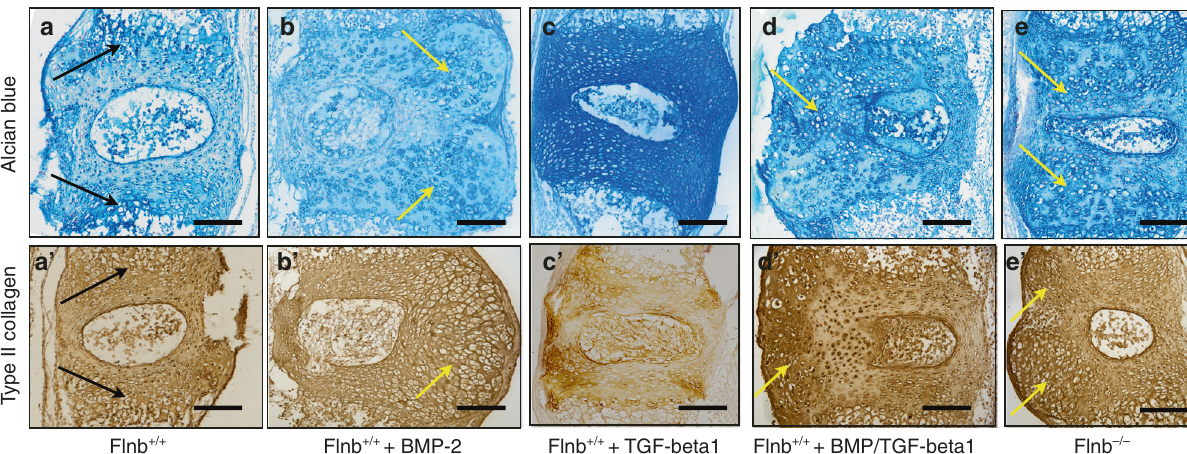
Fig. 5 Flnb + / + IVD stimulation with TGF β -1 and BMP-2 mimics the Flnb – / – phenotype, which is rescued by combinatorial inhibition of TGF β and p38 signaling. a – e Representative images of sagittal sections of T7-T8 cultured IVDs stained with Alcian Blue for proteoglycans. a Flnb + / + cultured spines show proteoglycans concentrated in the articular cartilage (black arrows). b BMP-2-stimulated Flnb + / + spines exhibited no change in proteoglycan secretion but severe disruptions in tissue architecture (yellow arrows). c TGF β -1-stimulated Flnb + / + spines showed no change in tissue architecture but increased proteoglycan secretion. d BMP-2- and TGF β -1-stimulated Flnb + / + spines exhibit increased proteoglycan secretion and disruptions in tissue architecture (yellow arrow). e Flnb – / – spine exhibiting increased proteoglycan secretion and disrupted tissue architecture (yellow arrows). a ’ – e ’ Representative images of sagittal sections of T7-T8 cultured IVDs stained for type II collagen via IHC-HRP. a ’ Type II collagen distribution is more evenly distributed throughout the IVD concentrated in the AC. b ’ BMP-2-stimulated Flnb + / + spines exhibit increased type II collagen secretion and severe disruptions in tissue architecture (yellow arrow). (C ’ ) TGF β -1 stimulated Flnb + / + spines, showing no change in tissue architecture or type II collagen secretion. d ’ BMP-2- and TGF β -1-stimulated Flnb + / + spines exhibit increased